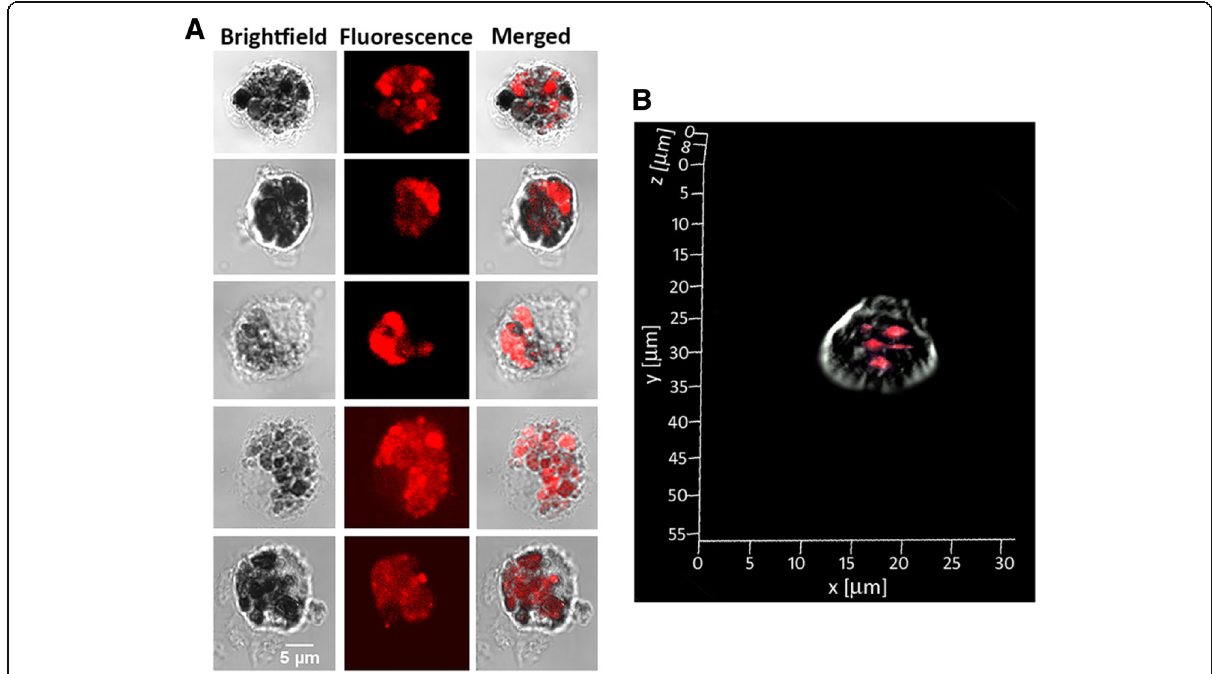
Fig. 6 Uptake of G0-OVA-AuNCs (3/4) by murine DCs measured by confocal microscopy. a Representative images of CD11c + cells after incubation with G0-OVA-AuNCs (3/4). b Z-stack image of a single dendritic cell representing uptake of G0-OVA-AuNCs inside the